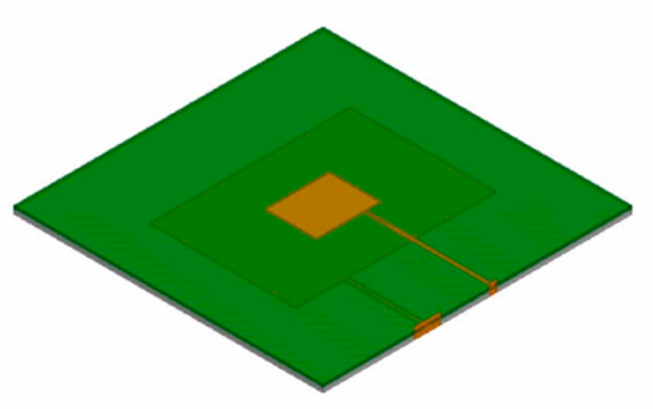
Figure 6. Schematic diagram of the simulation